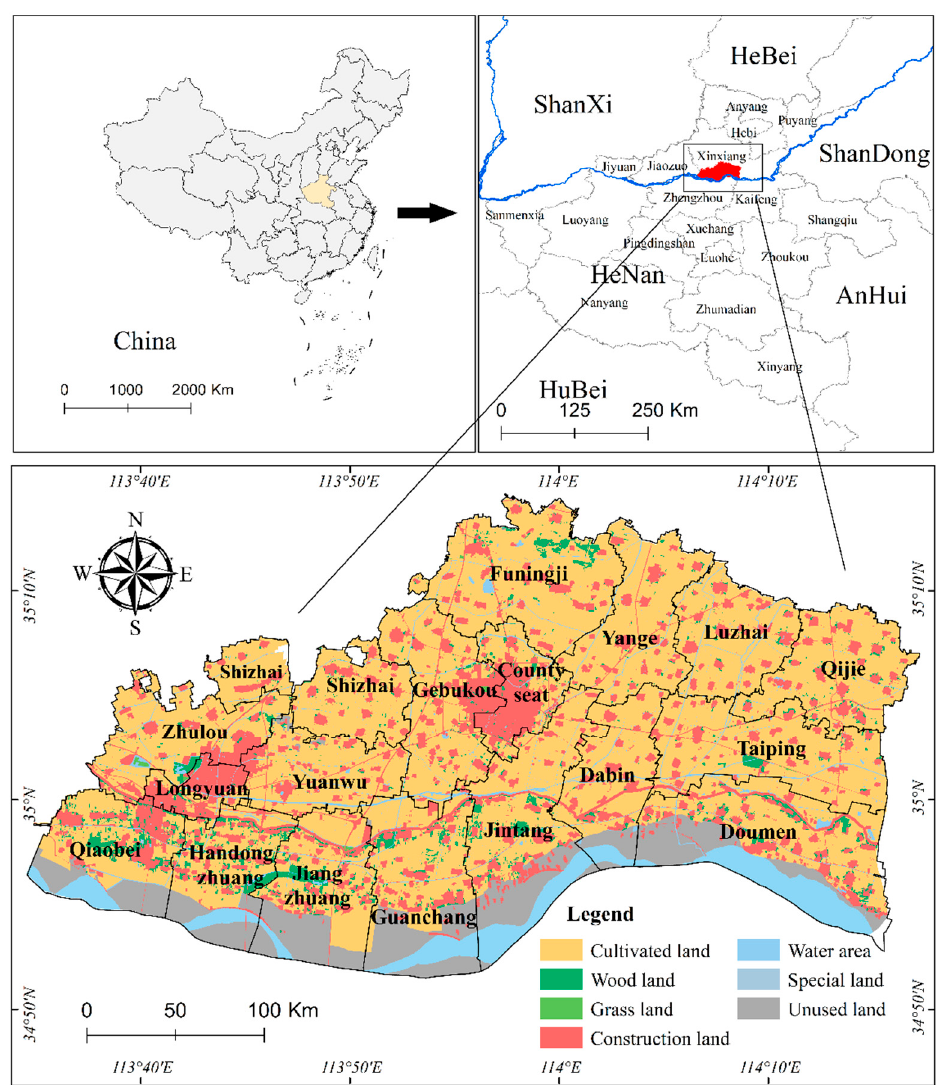
Figure 1. Location of the study area.